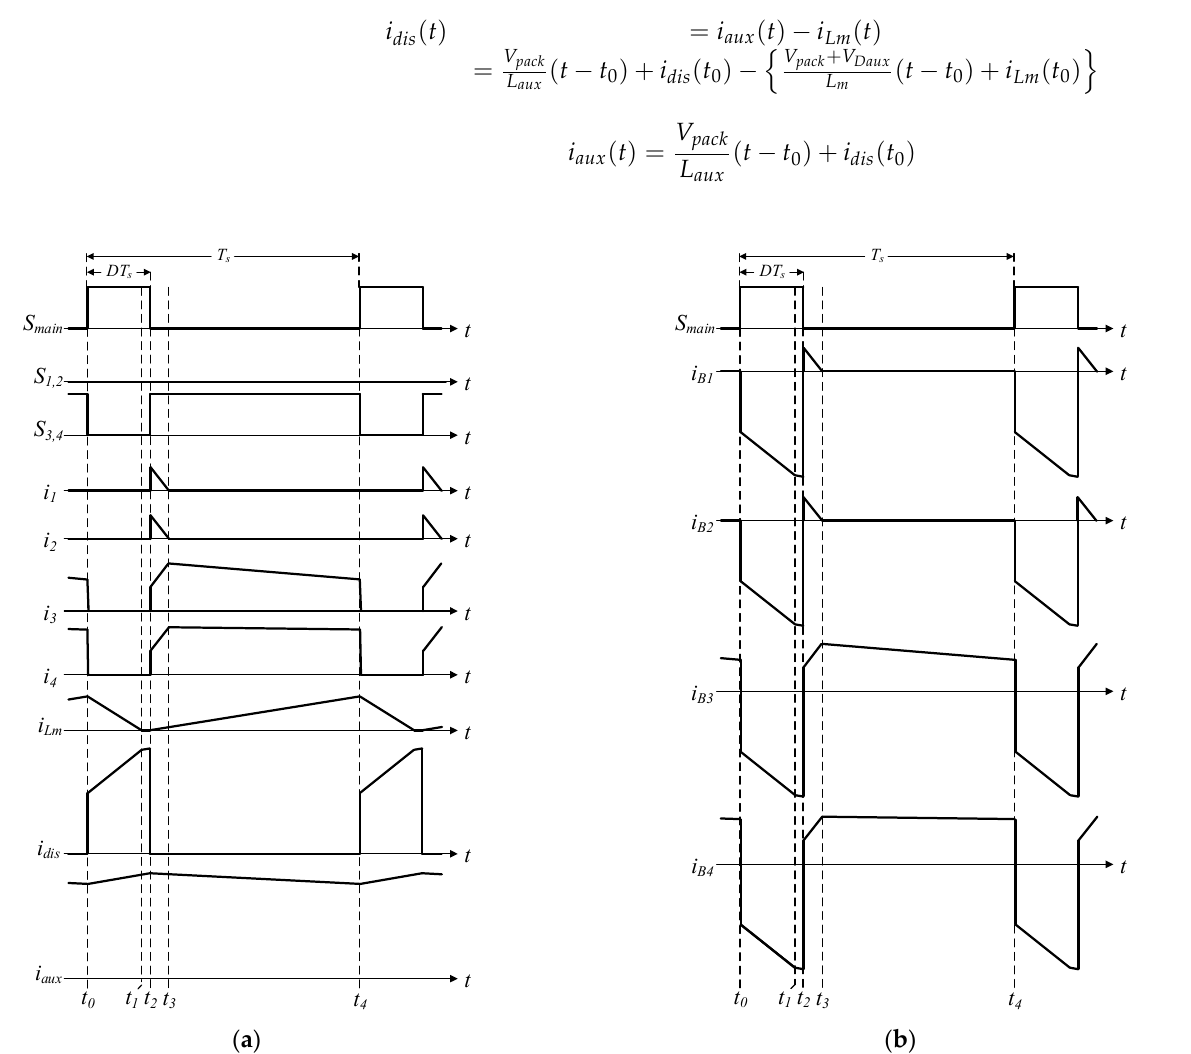
Figure 8. Key waveforms of the proposed circuit: ( a ) operating waveforms and ( b ) charge and discharge currents . (2) Mode 2 ( t 1 ~ t 2 ): Mode 2 begins at t 1 with i Lm , and converges to zero. In this mode, D aux is reverse-biased, and i dis is equal to i aux . The i dis is expressed as (7), and the slope